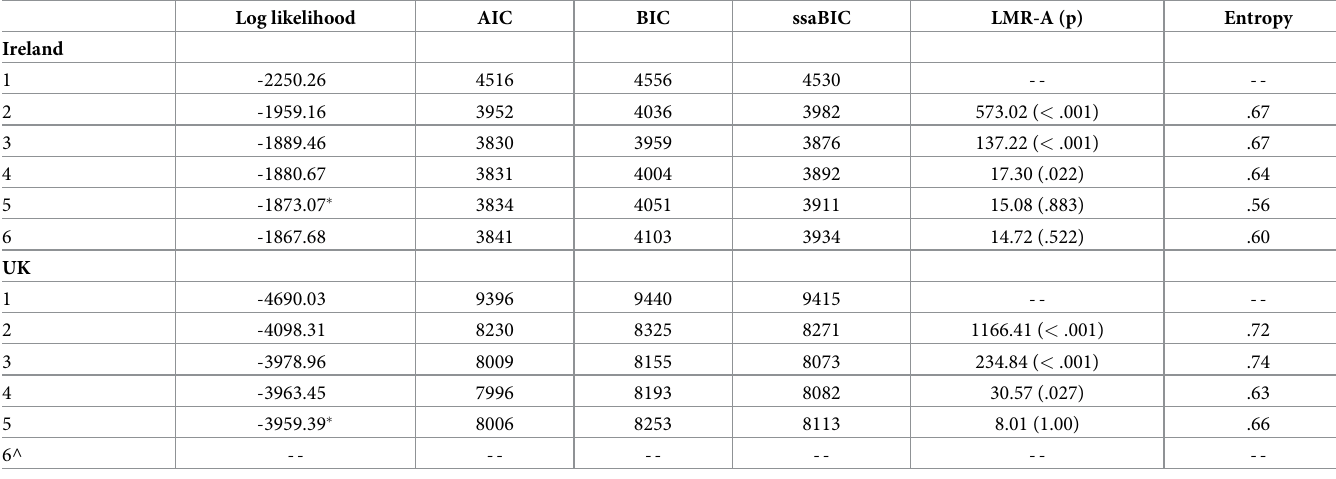
Table 3. Fit indices for latent class models in the Irish and UK samples. Log